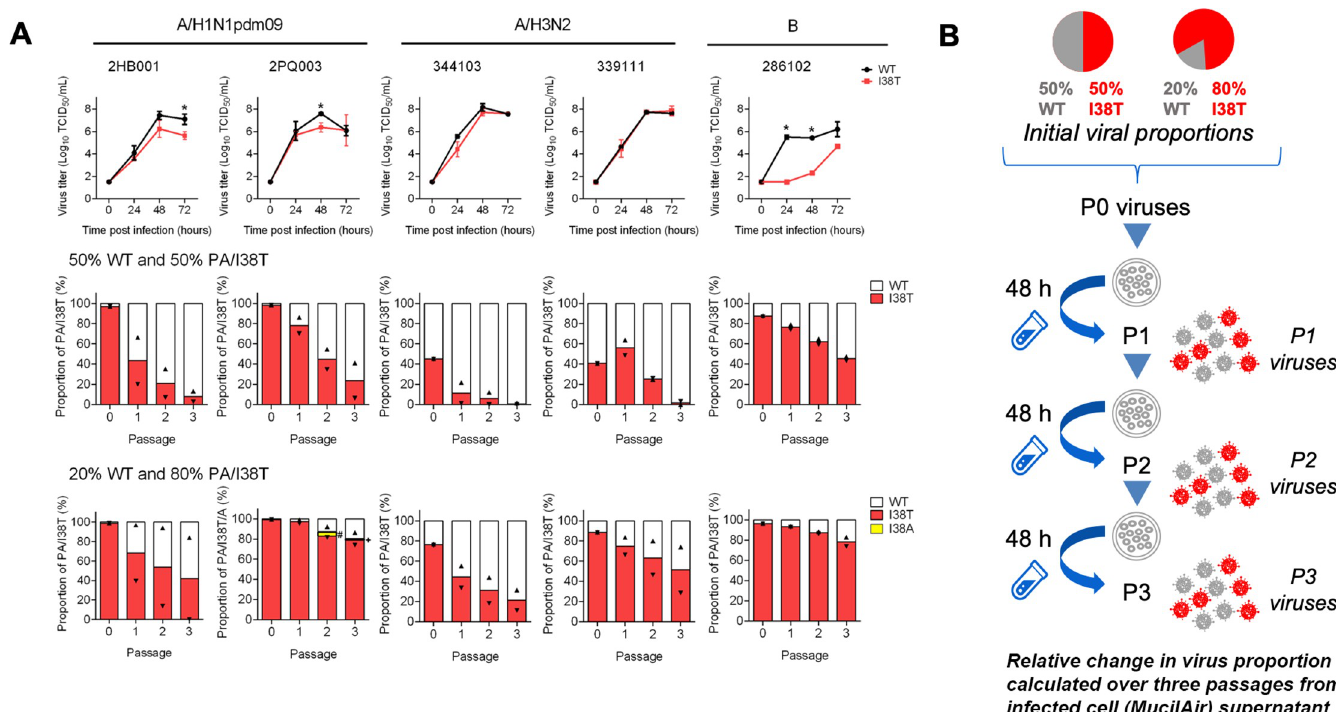
Fig 1. Replicative capacity and competitive fitness of influenza PA/I38T substituted A/H1N1pdm09, A/H3N2 and B viruses isolated from clinical samples. (A) MucilAir human nasal epithelial cells were infected with influenza clinical isolates at an MOI of 0.001 and 0.01 TCID 50 /cell for type A and type B viruses, respectively. Culture fluids were collected at 0, 24, 48 and 72 hours post-infection and viral titers were determined in MDCK-SIAT1 cells. The LLOQ for virus titer was 1.57 log 10 TCID 50 /mL and the viral titer lower than LLOQ was defined as 1.50 log 10 TCID 50 /mL. Statistical comparisons of virus titers between WT and viruses with PA/I38T at each time-point were conducted using Welch’s t -test at the 0.05 significance level ( � p < 0.05). Data represent mean ± SD of triplicate experiments. MucilAir cells were co- infected with WT and PA/I38T-substituted clinical isolates at 50:50 or 20:80 ratio based on viral titers (TCID 50 ) at an MOI of 0.002 and 0.02 for type A and type B viruses, respectively. At 48 hours post-infection, the culture fluids were collected and serially passaged three times at an MOI of 0.001 and 0.01 for type A and type B viruses, respectively. Each culture fluid was subjected to NGS to determine the population of amino acids at position 38 in the PA subunit. The lower detection limit for calling variant viruses was 1% and variant population less than the lower detection limit was set as 0 for the calculation. The bar and the triangles indicate the mean and the individual values of duplicate experiments, respectively. The symbols (# and +) indicate 3.8% and 1.5% of PA/I38A proportion. (B) Experimental setup for the competitive mixtures experiments is depicted. LLOQ, lower limit of quantitation; MOI, multiplicity of infection; NGS, next generation sequencing; PA, polymerase acid; SD, standard deviation; TCID 50 , 50% tissue culture infectious dose; WT, wild